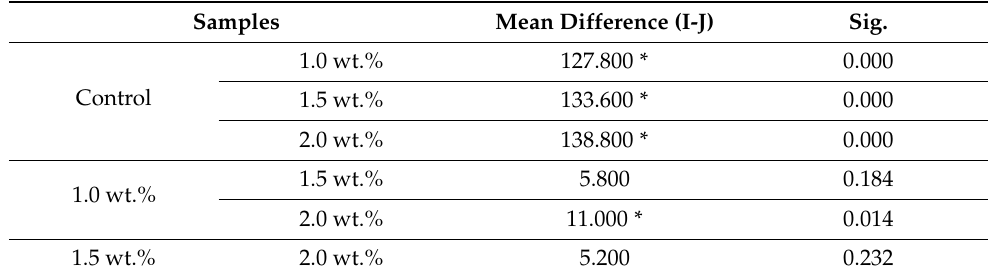
Table 4. Least significant difference (LSD) test applied on in. albicans viable count results of all the studied groups.